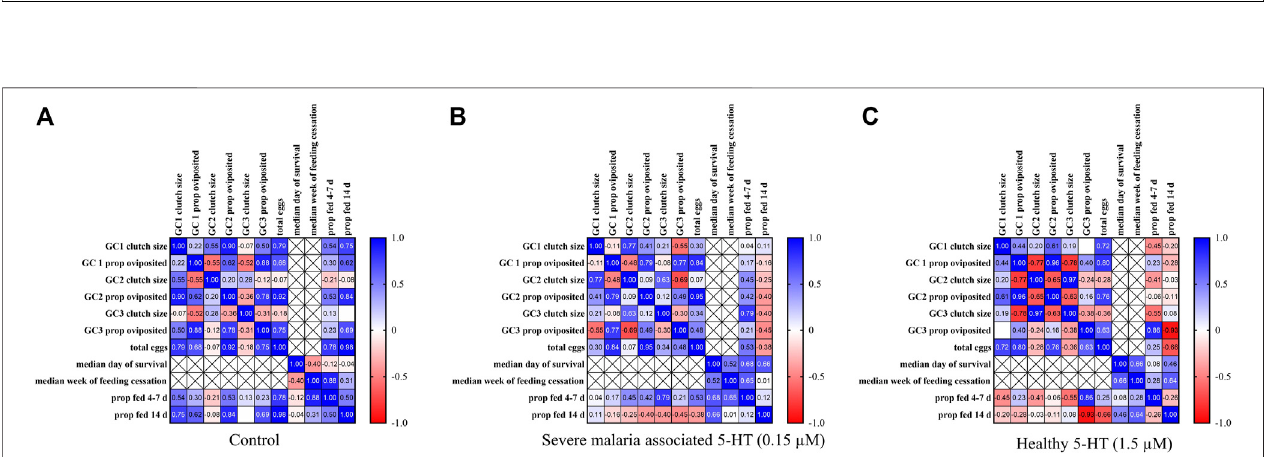
FIGURE 5 | Correlation matrices of parameters from uninfected A. stephensi provisioned with blood meals supplemented with serotonin (5-HT) or water (control). (A) Correlation matrix of data from mosquitoes provisioned with blood supplemented with a volume of water (control) equivalent to that used to deliver 5-HT treatment. (B) Correlation matrix of data from mosquitoes provisioned with blood supplemented with severe malaria associated levels of 5-HT (0.15 µM). (C) Correlation matrix of data from mosquitoes provisioned with blood supplemented with healthy levels of 5-HT (1.5 µM). N = 5; Procrustes analysis, *control vs. 0.15µM, p = 0.0480, *control vs. 1.5µM, p = 0.0229, *0.15µM vs. 1.5µM, p =